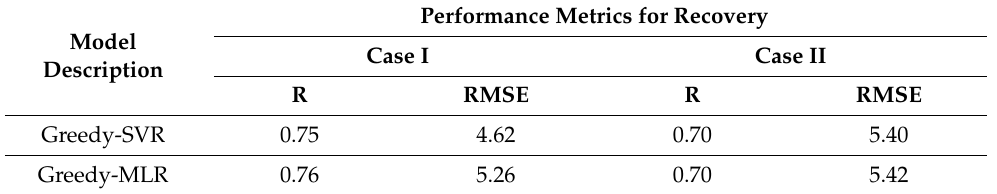
Table 9. Models performance metrics for Case I and II during